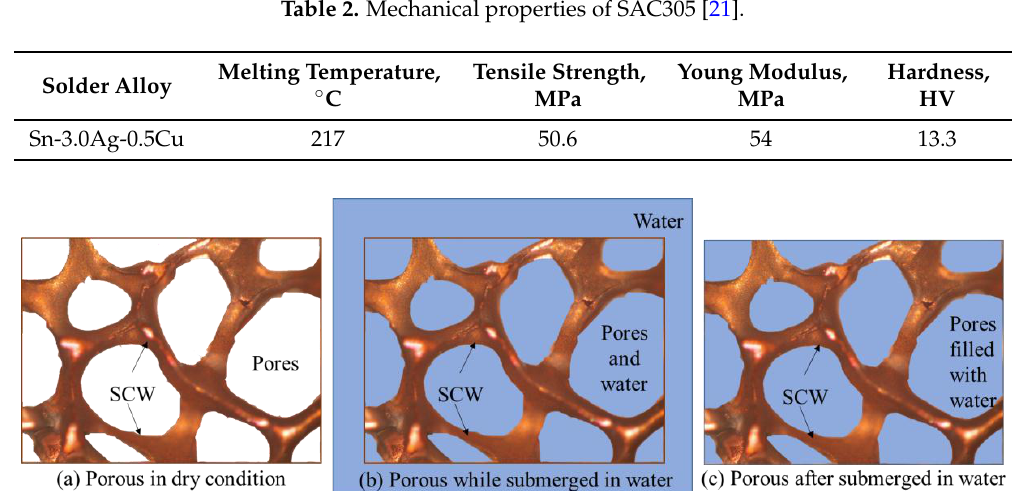
Table 1. Chemical composition of solder alloy (wt. %).